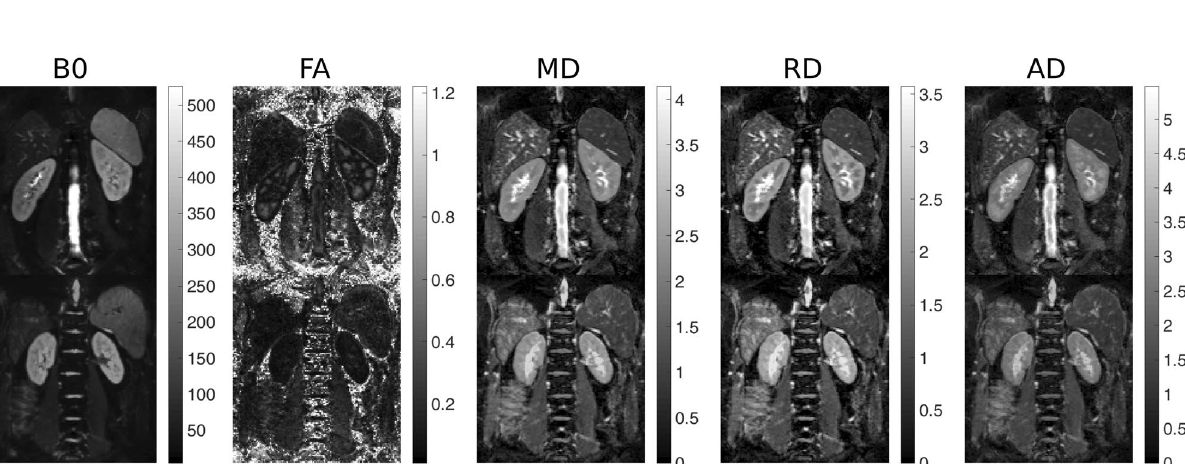
Figure 2. Diffusion Tensor Imaging maps for a Bardet–Biedl syndrome and a control subject. The baseline, b = 0 s/mm 2 DTI image (B0, left) and derived parametric maps (FA: fractional anisotropy, MD: mean diffusivity, RD: radial diffusivity and AD: axial diffusivity, respectively from left to right) for a control (upper) and BBS subject (lower). The FA images are represented in arbitrary units, whereas the MD, RD and AD images are represented in 10 –3 mm 2